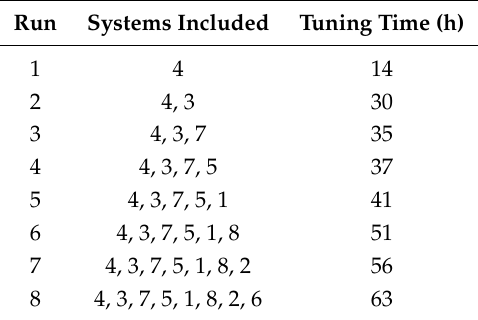
Figure 3. Experimental execution of the tuning process. Table 2. System sets used and the approximate tuning